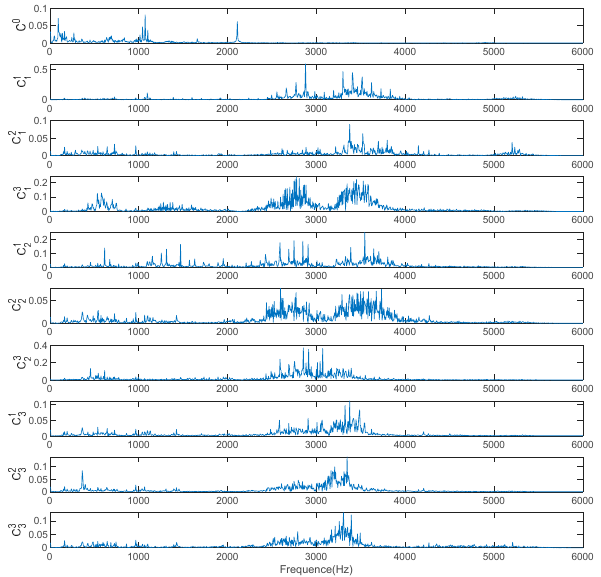
Figure 7. Fast Fourier transform (FFT) spectrum corresponding to the original vibration signals of 10 health states.